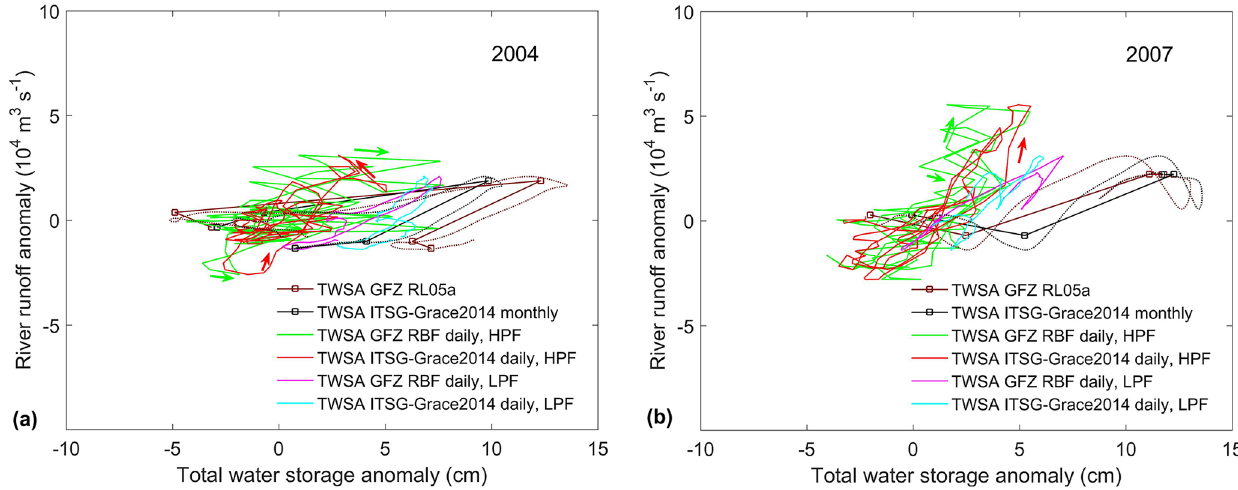
Figure 10. Anomalies of river runoff vs. total water storage for (a) 2004 and (b) 2007. A high-pass filter (HPF) with a 31-day window separates daily data into a HPF and an LPF component. A cubic spline interpolation (dotted line) is fitted to the monthly data. The LPF signals and monthly data have the mean seasonal cycle removed. Arrows indicate (local) directions in the HPF signal hysteresis